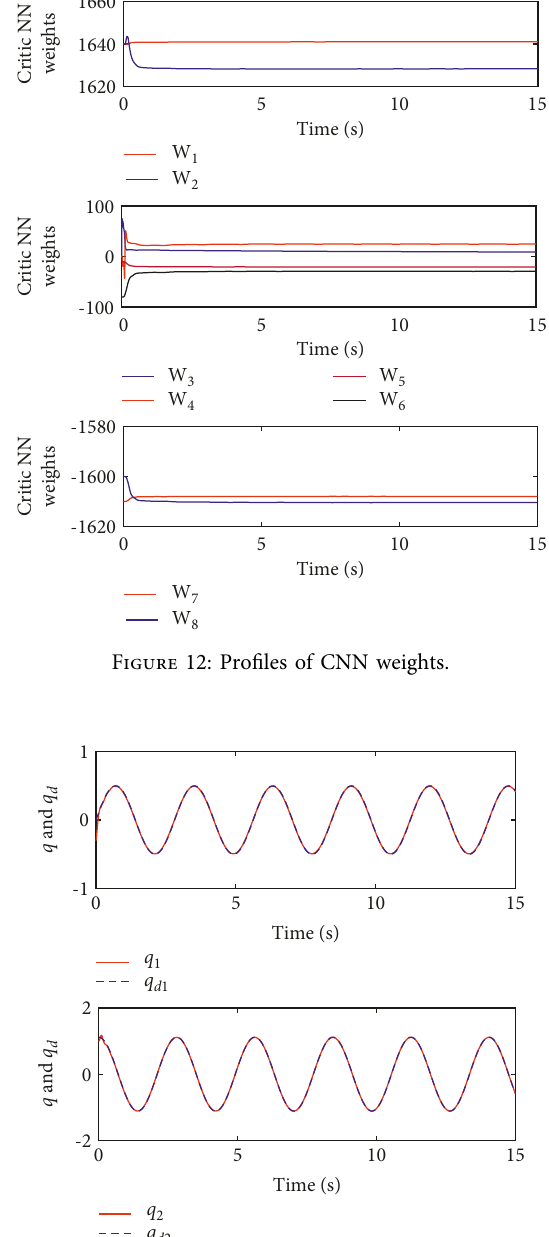
Figure 13: Tracking performance for q